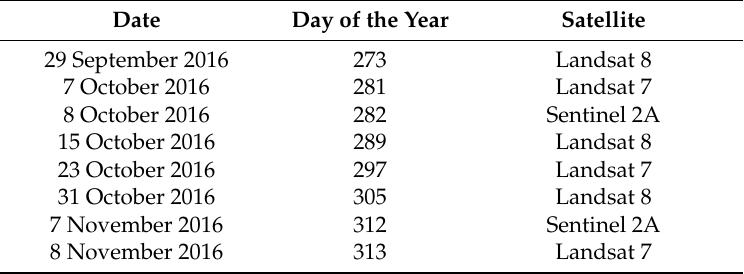
Table 1. Satellite imagery used for model validation during the lettuce growing